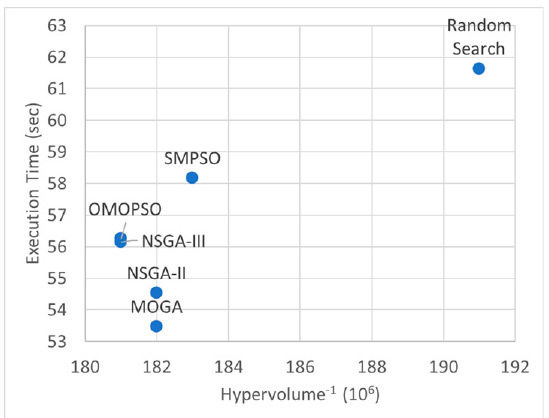
Figure 15. Plot chart mapping the studied algorithms according to the ET and the HV − 1 .